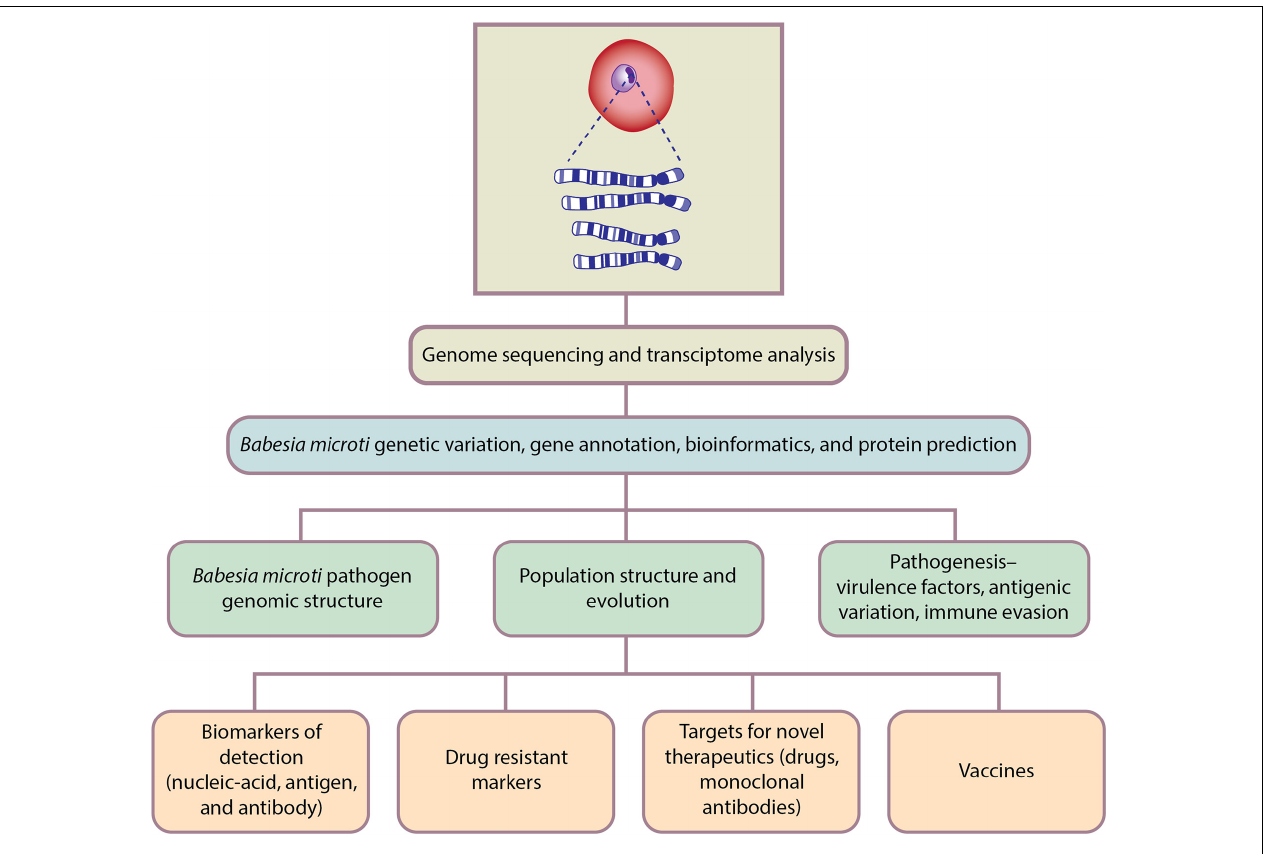
FIGURE 3 | Genomics-based approaches for Babesia microti detection, molecular surveillance, understanding pathogenesis and developing